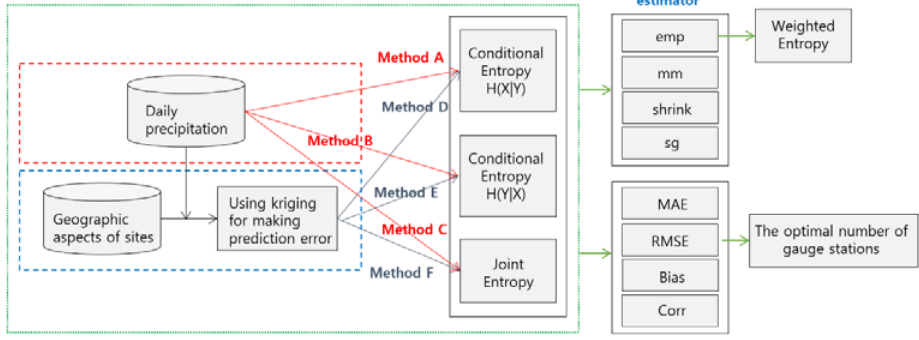
Figure 1. Research flowchart.